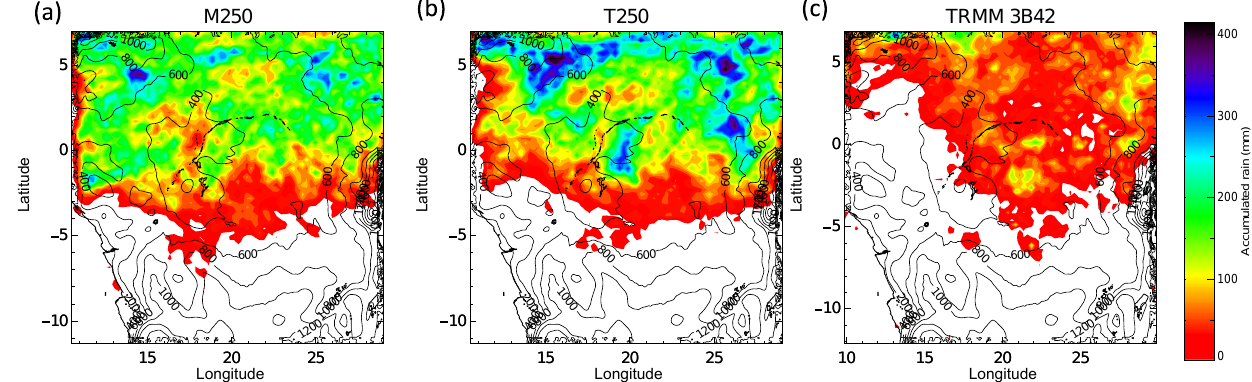
Figure 3. Congo case: accumulated surface precipitation (mm) from 1 to 10 August 2007 in the Congo basin, showing data from (a) CONGO- M250, (b) CONGO-T250 and (c) observations from the TRMM 3B42 gridded 3-hourly mean merged precipitation product. The simulation data shown in this figure have been coarsened to the 0.25 ◦ spatial resolution of the TRMM